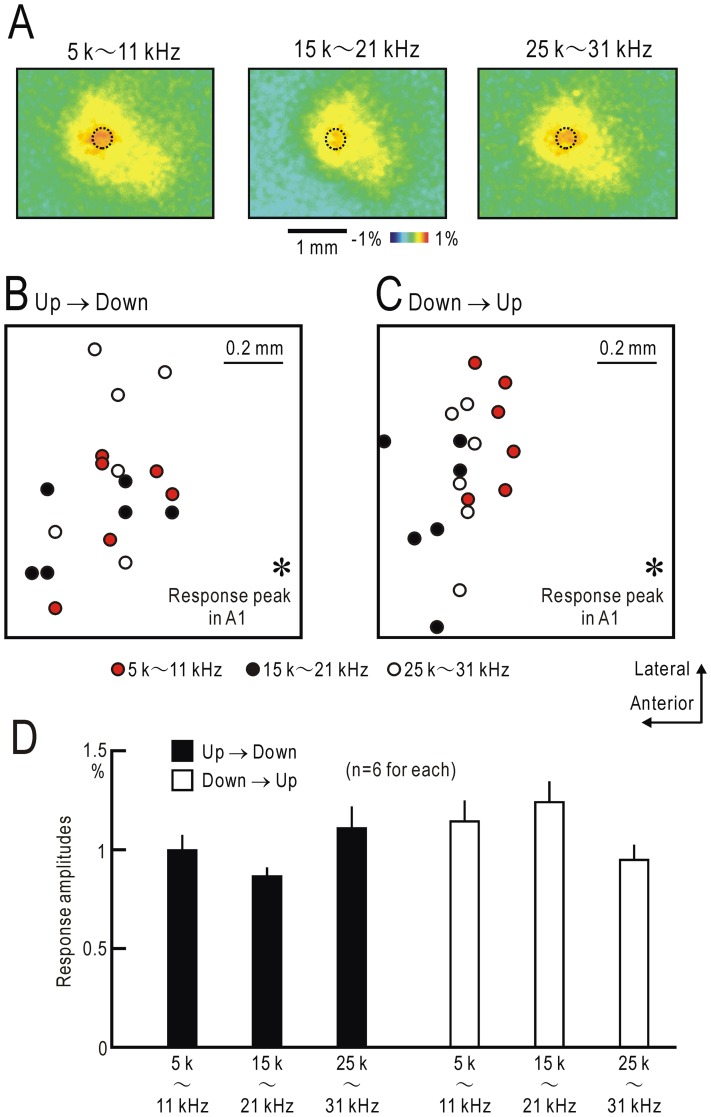
Absence of tonotopic maps in UF.(A) Cortical responses to FM direction reversal from upward to downward recorded in a mouse. The frequency ranged 5–11 (left), 15–21 (middle), or 25–31 kHz (right). The same responding area that approximately corresponded to UF is marked with dotted lines to assist comparison of responses shown in each panel. (B) The spatial distribution of response peaks to FM direction reversal from upward to downward in UF of 6 mice (circles). The relative locations of the response peaks to a 20 kHz AM sound in A1 (asterisk) are shown. (C) The spatial distribution of response peaks to FM direction reversal from downward to upward in UF of the same 6 mice. (D) Response amplitudes to FM direction reversal from upward to downward, and downward to upward for each frequency range.